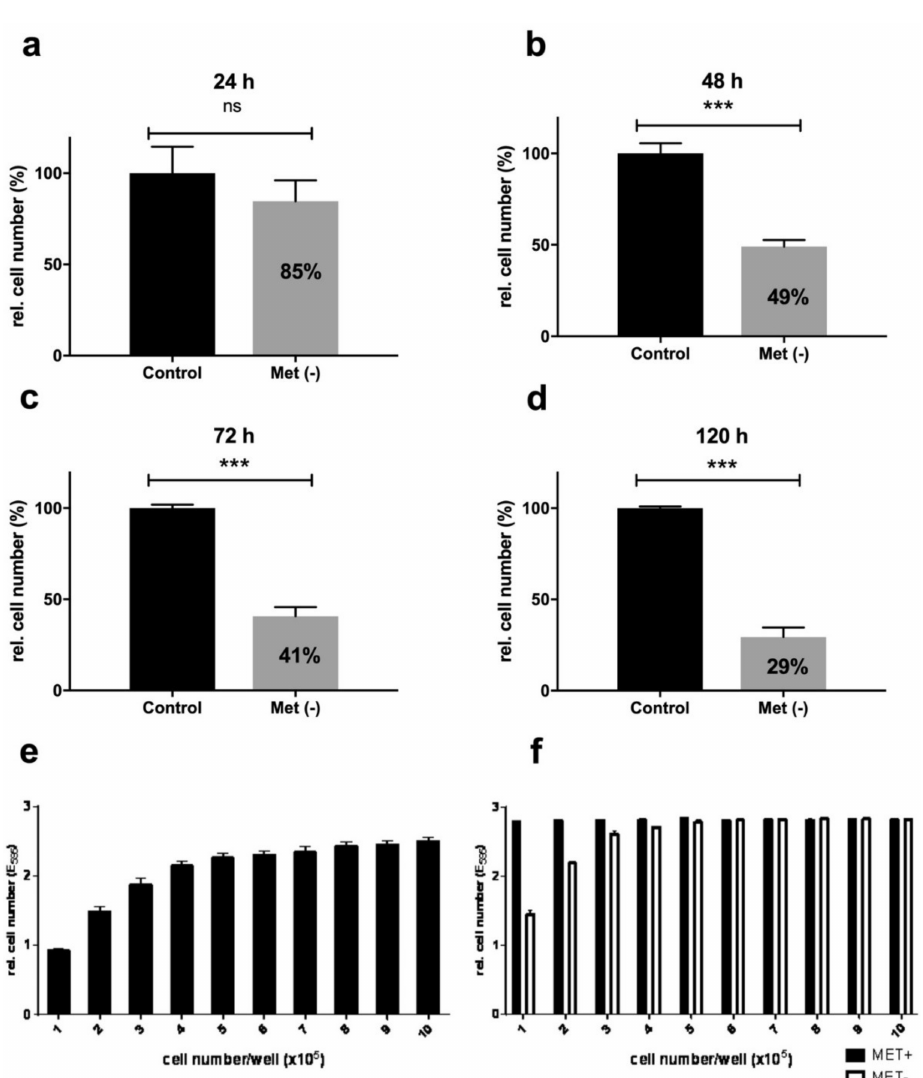
Figure 1. ( a – f ) Analysis of L929 cell proliferation in the presence and absence of methionine. A total of 10,000 cells were seeded per well, incubated overnight and stimulated for 24 h, 48 h, 72 h and 120 h with or without methionine. The proliferation of the cells was analysed by crystal violet staining as described in the Materials and Methods. ( a – d ) The figures show a summary of the results obtained from four independent experiments (five values for every group). The control was normalized to 100%. ( e , f ) Simple analysis of potential cell death. Subfigures ( e ) and ( f) show the results from one representative experiment. Unpaired Student’s t -test was used for comparison between control and Met ( w / o ) groups. p -values <0.05 indicated statistically significant effects. (ns: non-significant, *** p ≤